Question: Does the figure show an increasing or a decreasing trend?
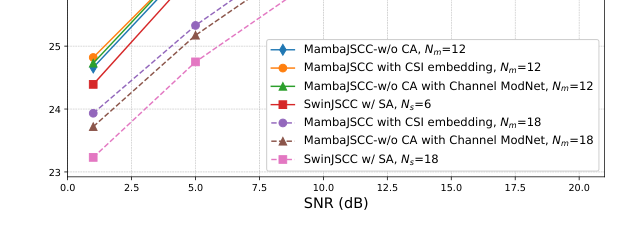
Answer: increasing